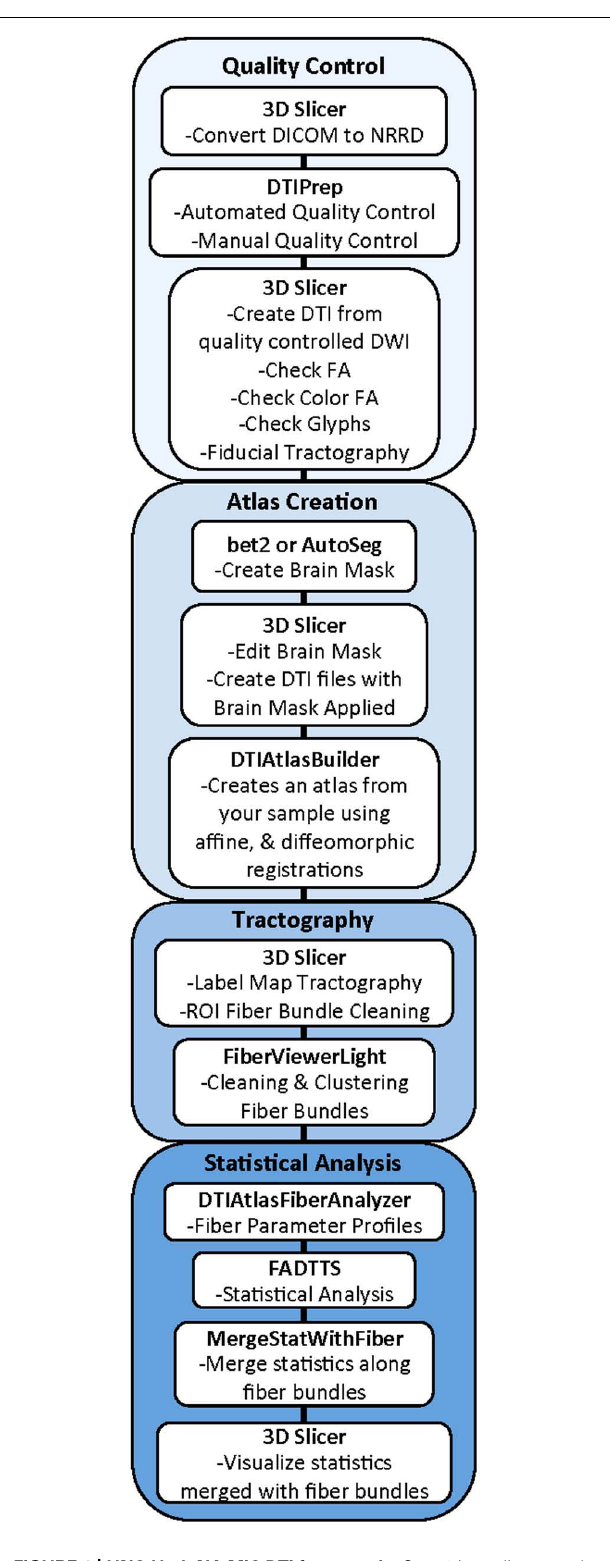
FIGURE 1 | UNC-Utah NA-MIC DTI framework. Step 1 is quality control. Step 2 is atlas creation. Step 3 is interactive tractography. Step 4 is parameter profile creation and statistical